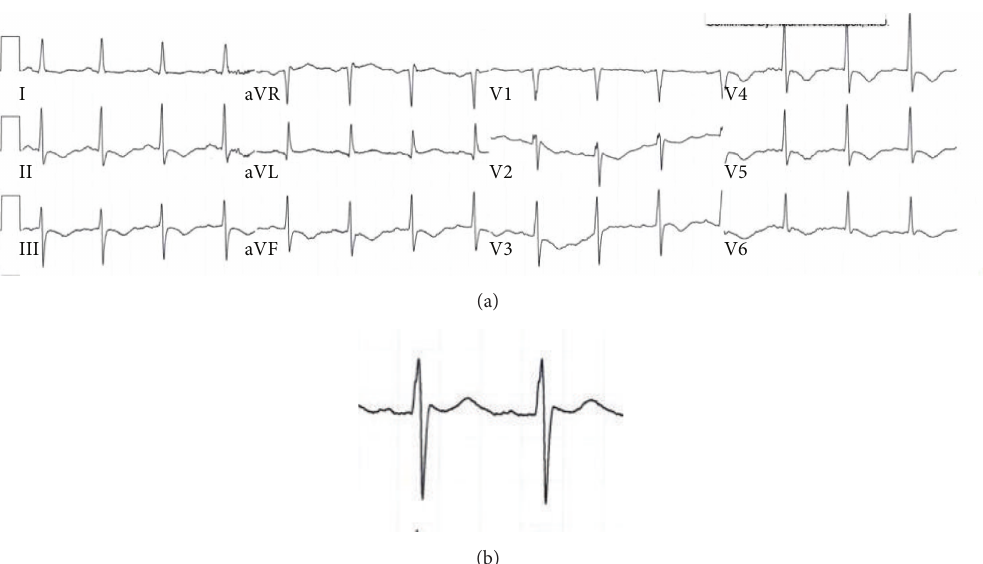
Figure 2: (a) After 12 hours of admission, progressive T wave inversion; the QTc is being prolonged of 491 ms. (b) Close-up of lead